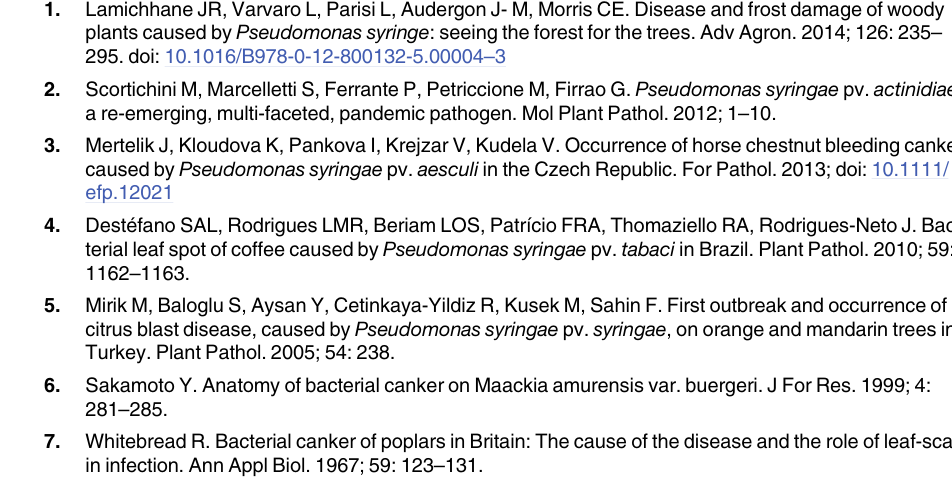
S2 Table. Results of pathogenicity tests on hazelnut. S3 Table. Multilocus Sequence Typing analysis sequences used to compare Pav strains. S4 Table. Number of Pav isolates obtained from the study sites. S5 Table. Results of the phenotypic